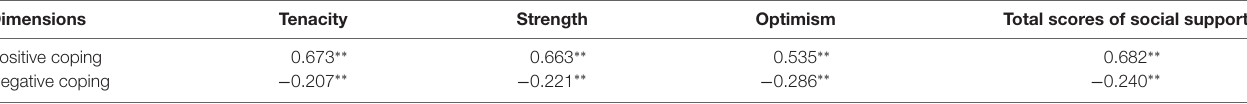
TABLE 8 | Correlation between total score of psychological resilience and coping styles in patients with complicated hepatolithiasis ( r ).